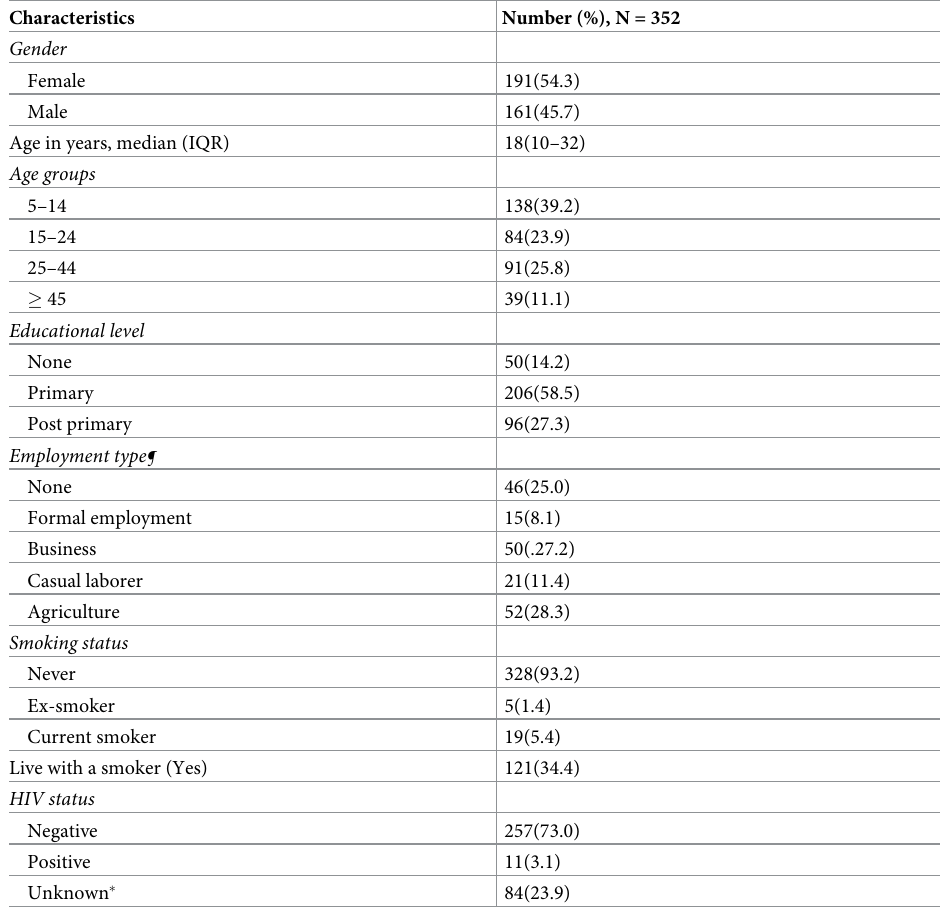
Table 1. Participants’